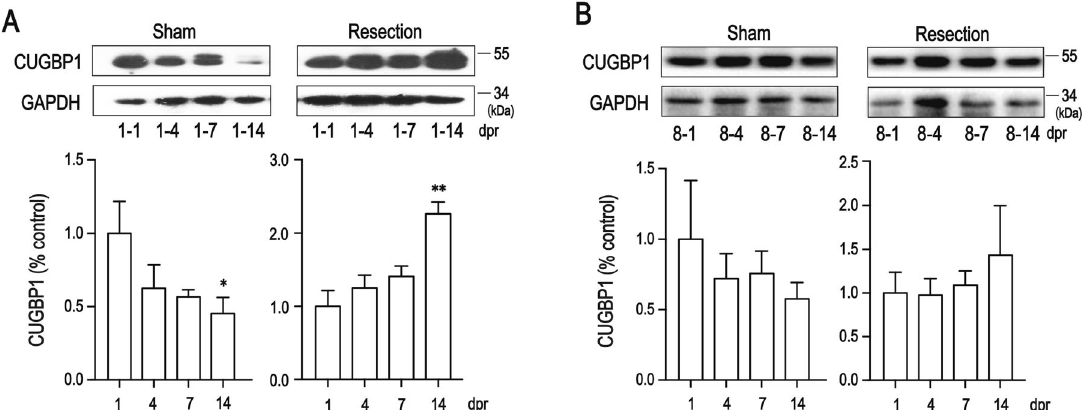
Fig. 1 CUGBP1 abundance is upregulated after apical resection. One-day ( A ) or 8-day ( B ) old mice were performed sham or apical resection surgery, CUGBP1 levels in cardiac tissue samples were detected by western blot analysis at 1,4,7,14 days post resection. Western blot bands were quanti fi ed by densitometry and normalized to GAPDH. dpr, days post resection. Data are the mean ± SEM ( n = 4 – 6). * p < 0.05, ** p < 0.01 vs.